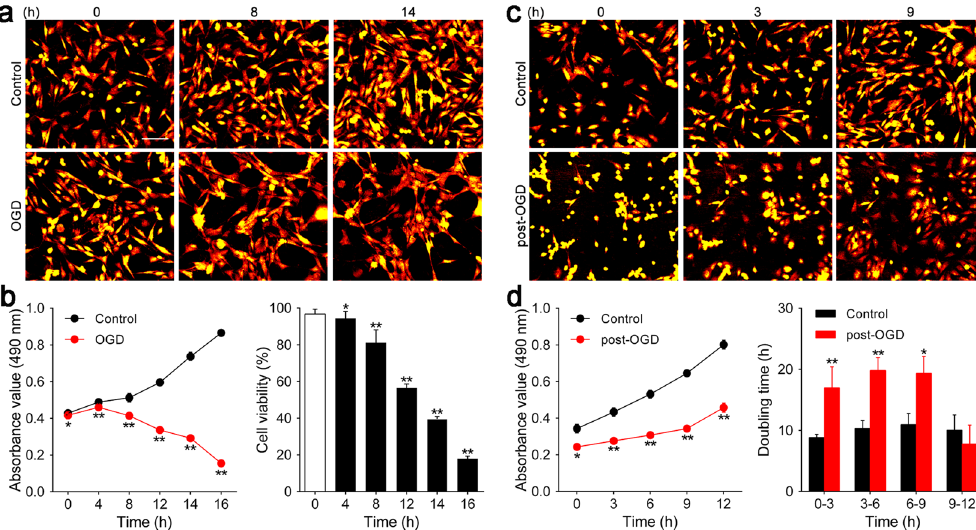
Figure 1. Determination of OGD and reoxygenation exposure times for HT-22 cells. ( a and c ) Digital hologram microscopy was used to acquire representative images showing changes in HT-22 cell number and morphology during the OGD and reoxygenation phases. Scale bar = 100 μ m. ( b ) A growth curve was generated using absorbance values (490 nm) and cell viability was detected by MTS assay at 0, 4, 8, 12, and 16 h of OGD. ( d ) HT-22 cell absorbance values (490 nm) at 0, 3, 6, 9, and 12 h of reoxygenation were used to construct the growth curve. Doubling time during 0–3, 3–6, 6–9, and 9–12 h of reoxygenation was calculated. * p < 0.05, ** p < 0.01 vs . control group. Also see Supplementary Figures S1, S2 and Videos S1,